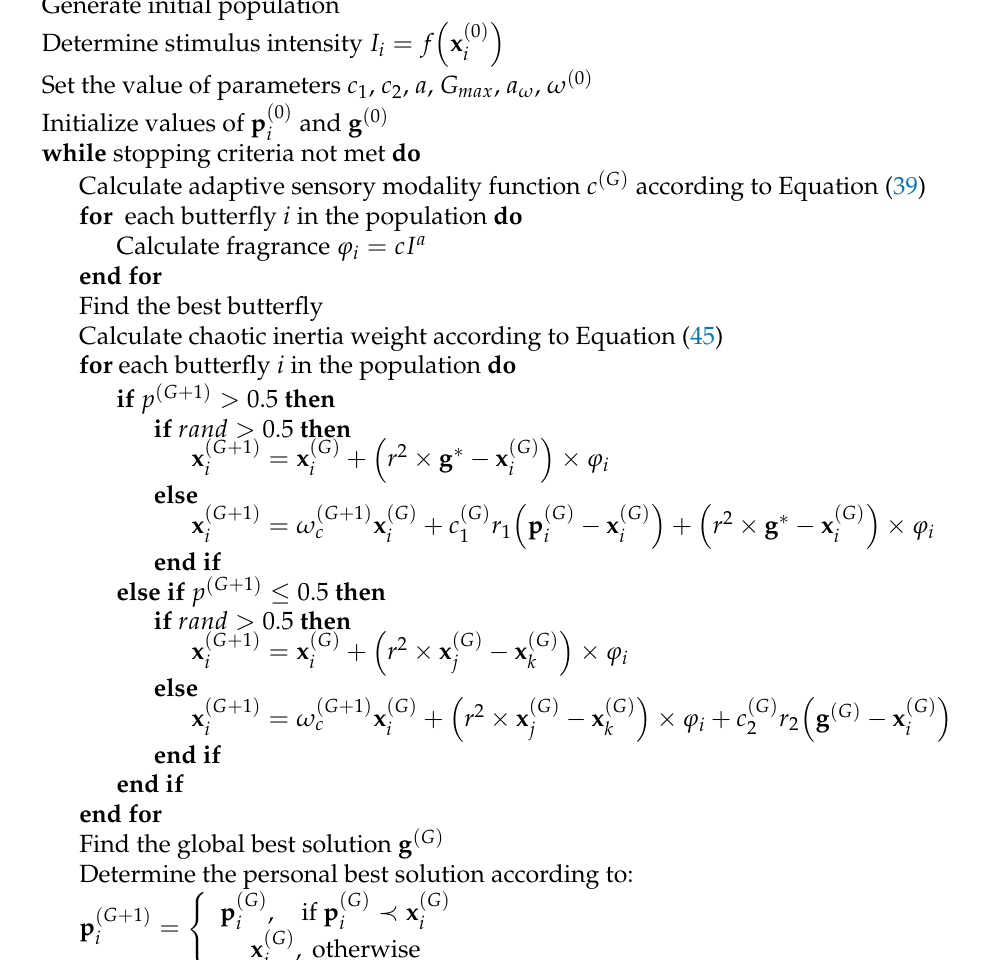
Algorithm 2 Pseudo-code of the proposed CAHBPSO algorithm. Generate initial